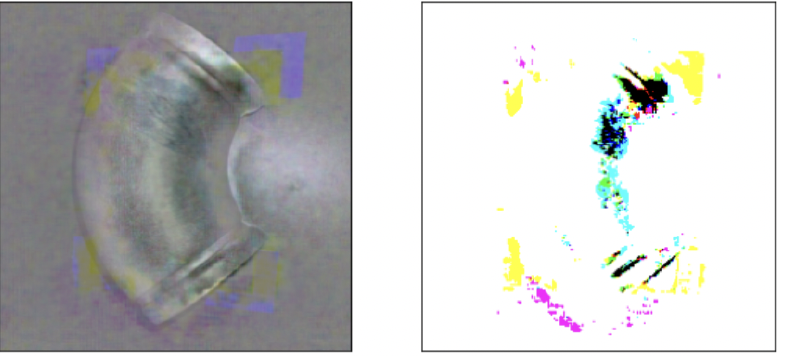
Figure 13. Localization images.